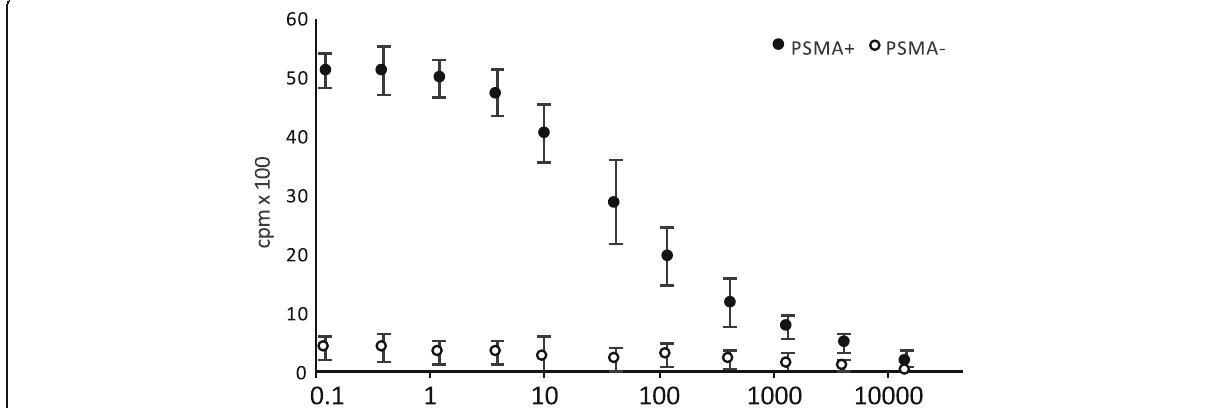
Fig. 3 Binding of 68 Ga-THP-mal-J591c-scFv to DU145 parental and DU145-PSMA cell lines in the presence of increasing quantities of J591c-scFv. Each data point is a mean of 3 measurements ± SD